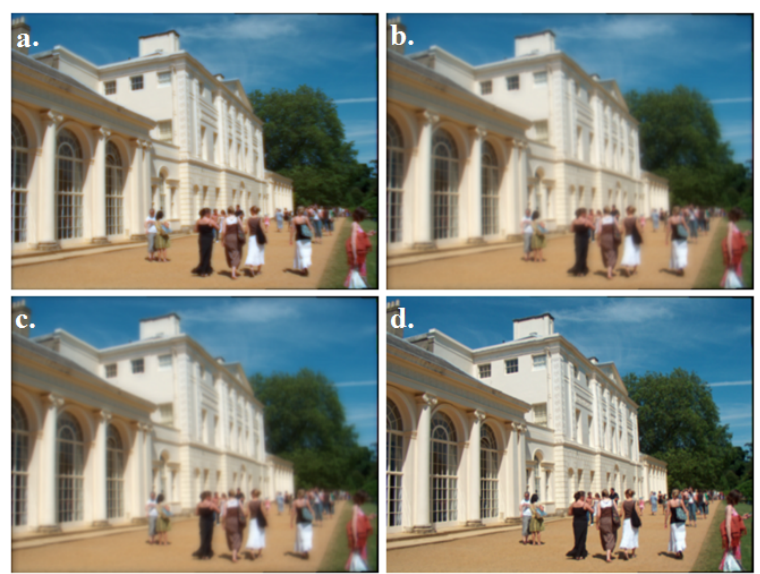
Figure 7. Human eye retinal image simulation ( a ) without CL, ( b ) with PMMA CL, ( c ) with 0.005 PMMA-TiO 2 CL, and ( d ) with 0.01 PMMA-TiO 2 CL.